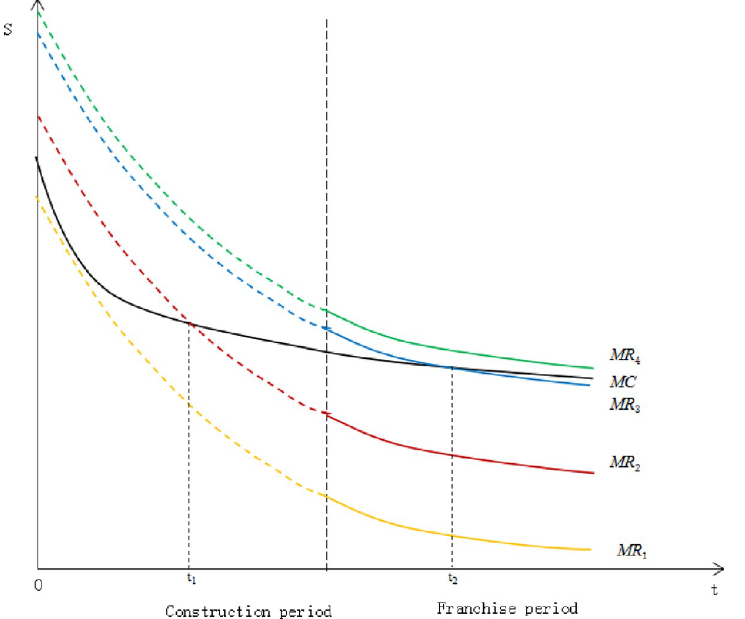
Fig 2. The intersection of MC and MR curves. (Source: author’s